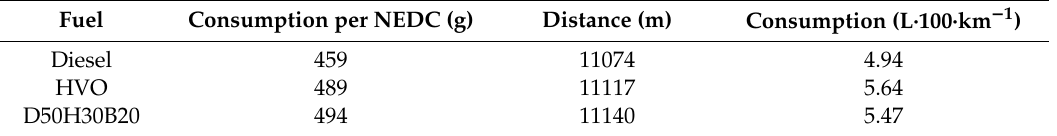
Table 9. Summary of fuel consumption and distance travelled during NEDC.